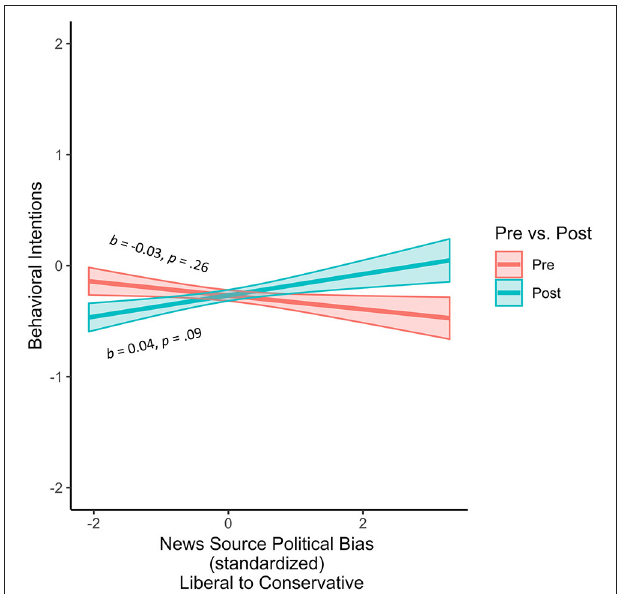
FIGURE 5 | Behavioral intentions as a function of time x news source. F (1, 562) = 2.24, p = 0.02, 95% CI[ < 0.01, 0.06], PRE = 0.01; Scale bands represent 95% confidence intervals.